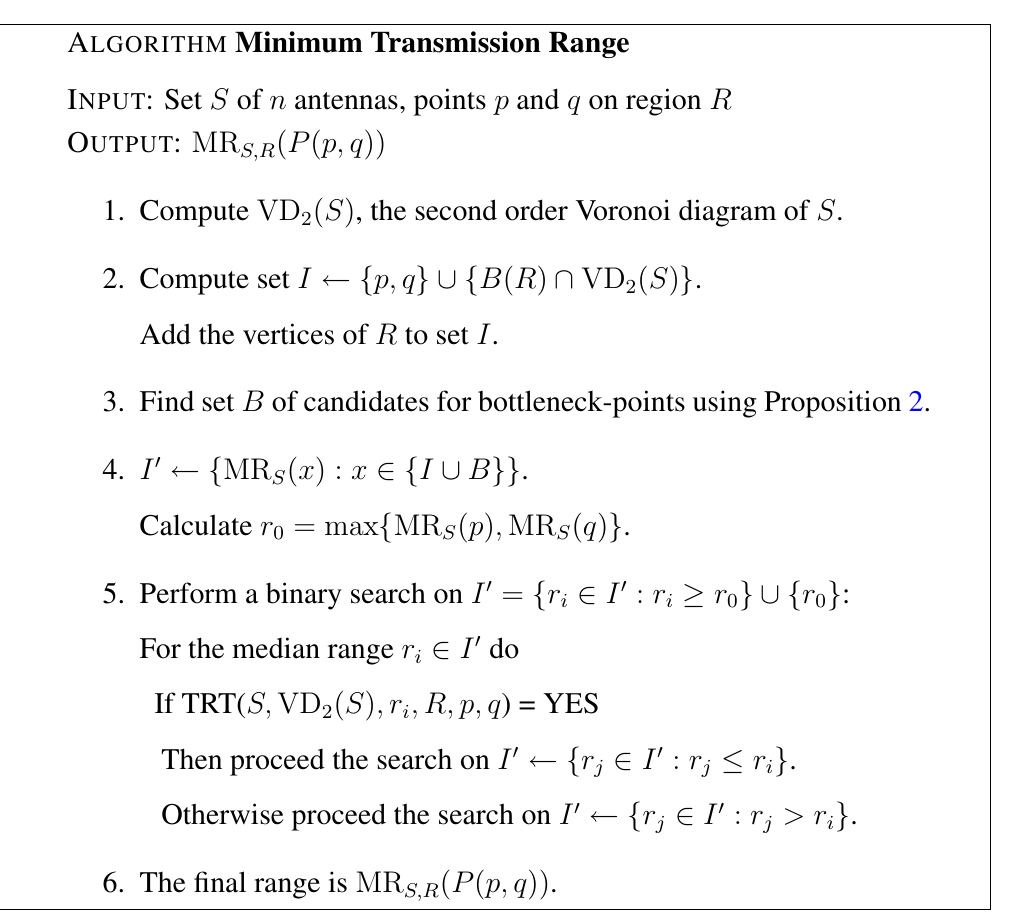
Figure 12. The antennas’ range is r = MR line. (a) Point b = b